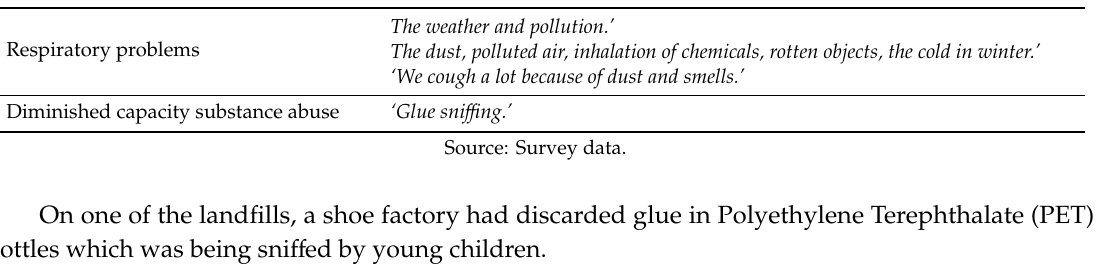
Table 8. Chemical-related health risks mentioned by waste